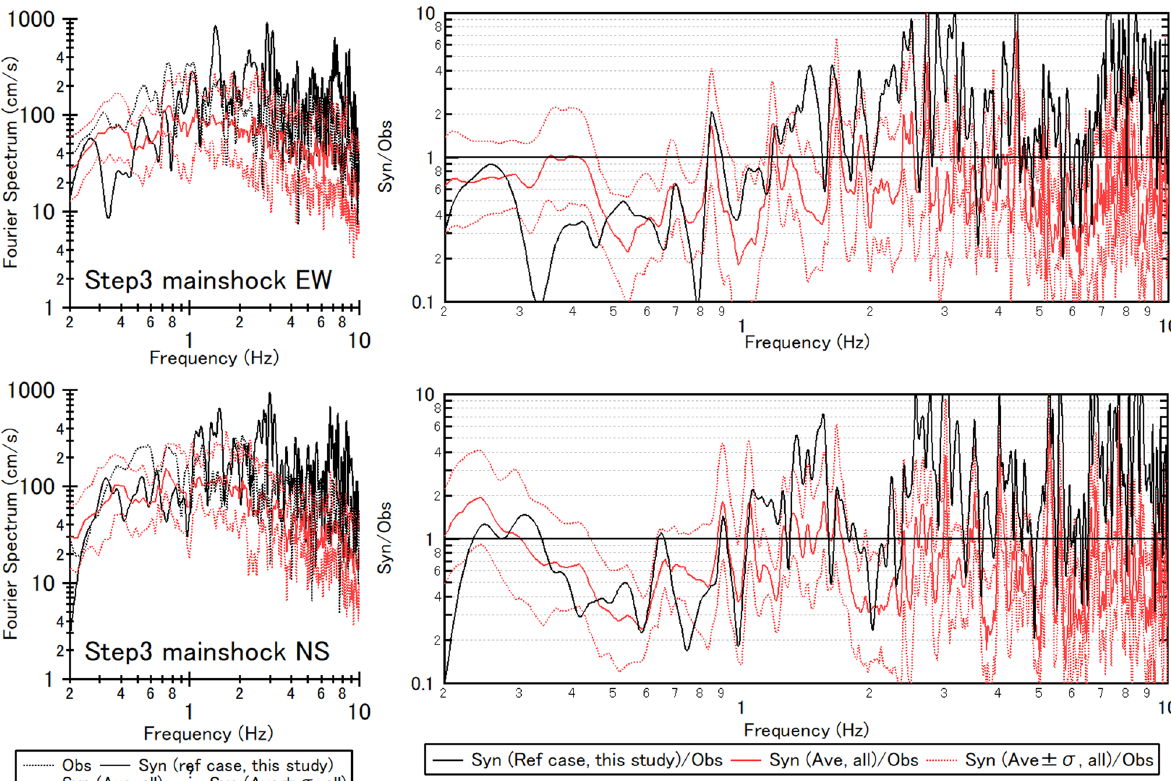
Fig. 17 Comparisons of the predictions by this study and other blind prediction participants for the earthquake of 2016/04/16 01:25 ( M w 7.1). (Left) Black dashed and solid lines indicate the observed spectra and the synthetic spectra of the reference case (Table 2) in this study, respectively. Red solid and dashed lines indicate the average and average σ spectra of all participants, respectively. (Right) Black and red lines indicate the ratio of ± the lines of same type in the left panel to the observed spectrum